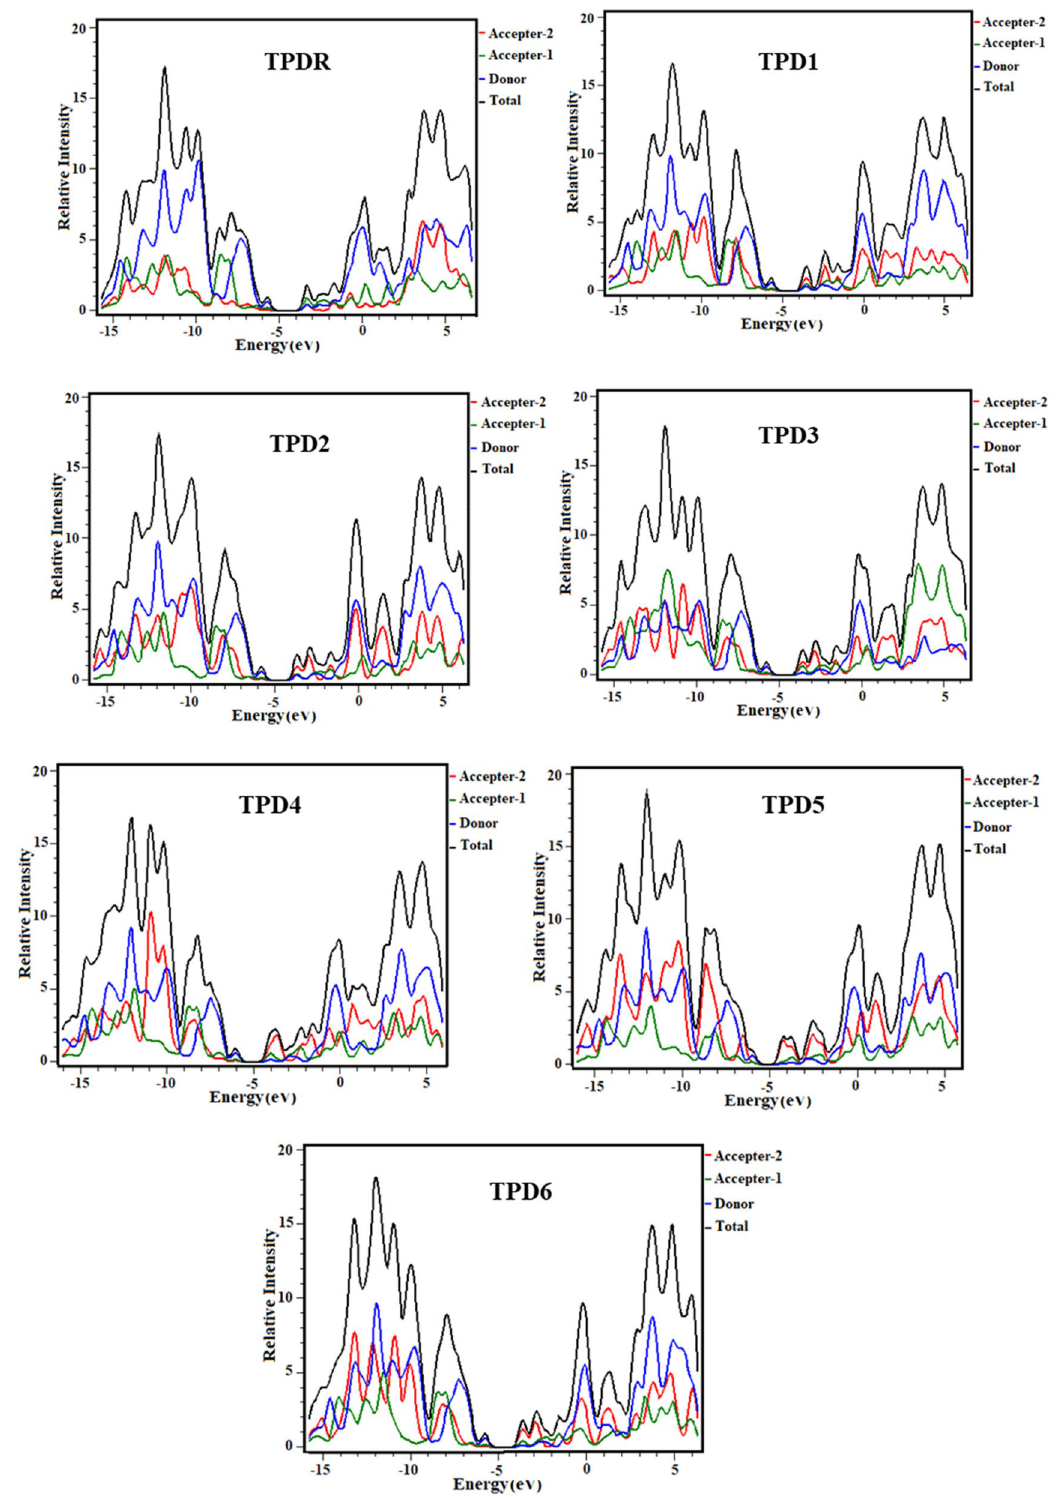
Figure 5. Graphical representation of the density of states (DOS) of studied chromophores drawn by utilizing PyMOlyze 1.1 version (https:// sourc eforge. net/ proje cts/ pymol yze/). All out put files of entitled compounds were computed through Gaussian 09 version D.01 (https:// gauss ian. com/ g09ci